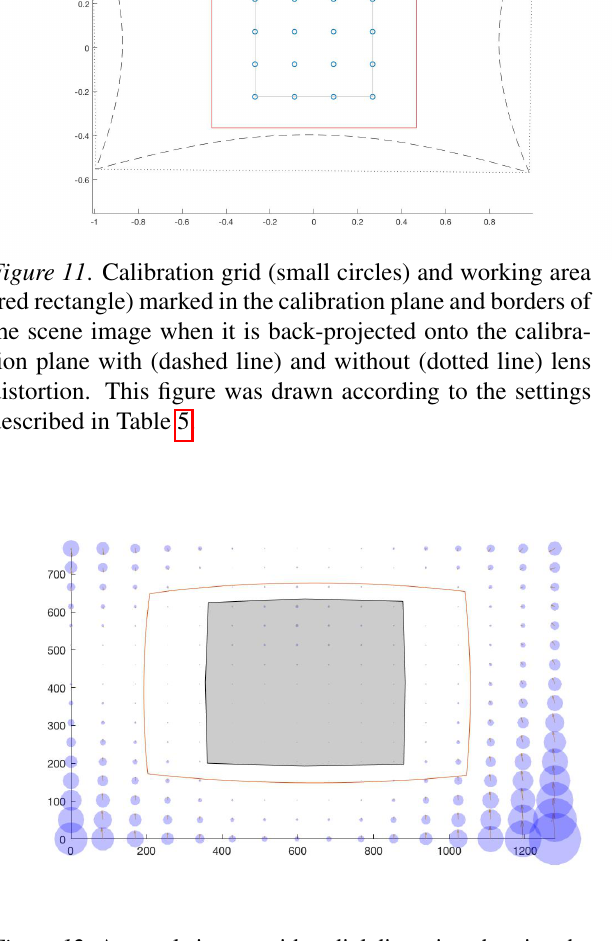
Figure 12 . A sample image with radial distortion showing the calibration region (gray) and the working area (red curve).